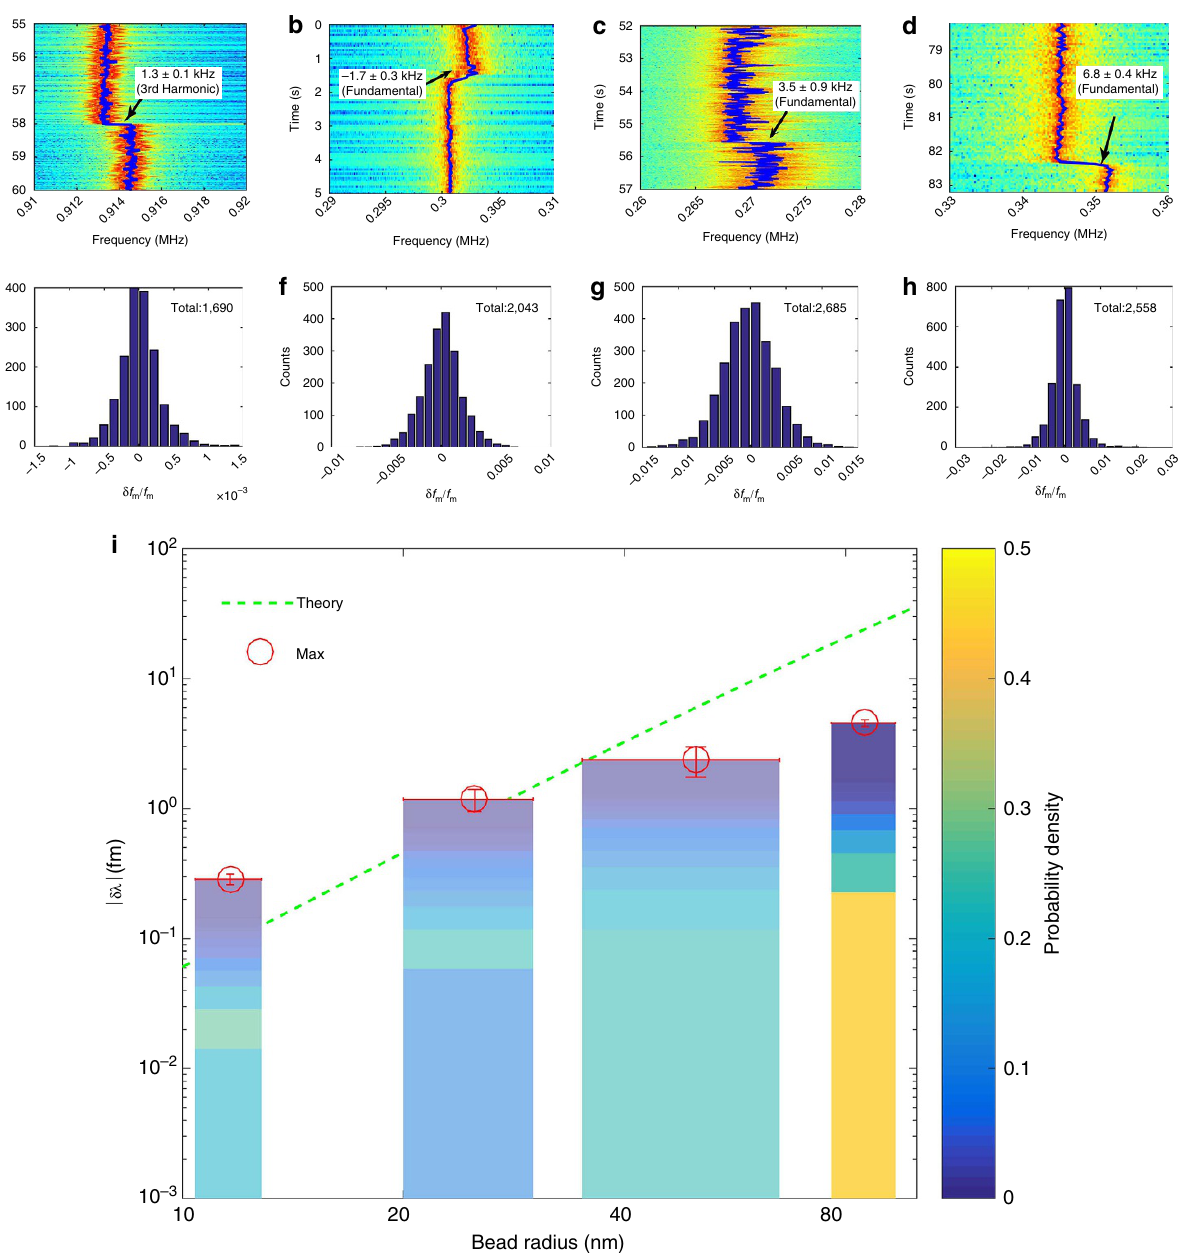
Figure 3 | Detection of silica nanobeads. ( a – d ) Typical mechanical spectrograms for the binding events of silica beads with average radii of 11.6, 25, 50 and 85nm, where a shows that of third harmonic and b – d show those of the fundamental oscillation frequency. The blue solid lines are the peak frequency traces computed by a least square fitting of each spectrum to a Lorentzian function. ( e – h ) The histograms of the normalized frequency steps d f m / f m . ( i ) The corresponding cavity resonance shifts induced by the particle binding as a function of bead radius. The colour bars show the probability density functions of the recorded cavity resonance wavelength shifts induced by particle binding, where the bar width indicates the s.d. of the bead size (provided by the manufacturer) and the colour map indicates the magnitude of probability density. The red circles indicate the recorded maximum wavelength shifts of the cavity resonance with the s.d. of the difference between the measured data and the corresponding least square fitted step function represented by error bars. The dashed curve shows the theoretical prediction 30